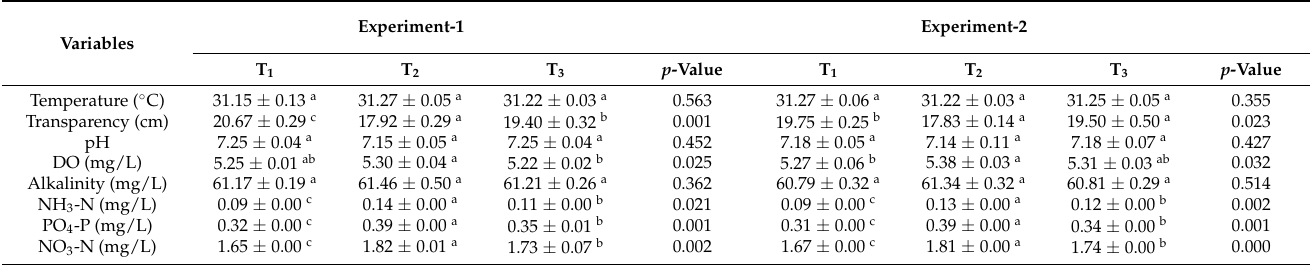
Table 1. Water quality parameters of a rice–fish–vegetable culture system (n = 3 for each experiment).